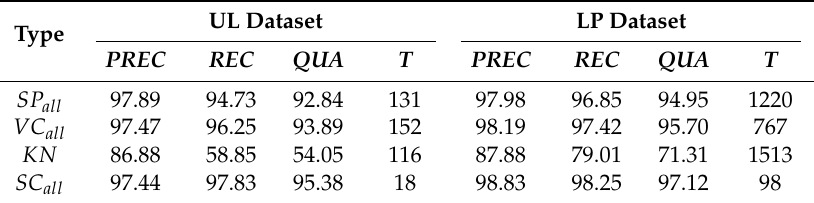
Table 4. PREC , REC , QUA (in %) and T (in s) for different neighborhood types and two datasets. UL Dataset UL Type Type